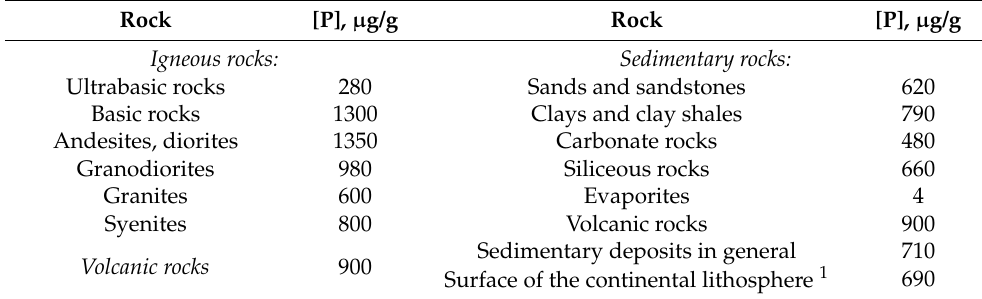
Table 3. Content of phosphorus in rocks [8,9].